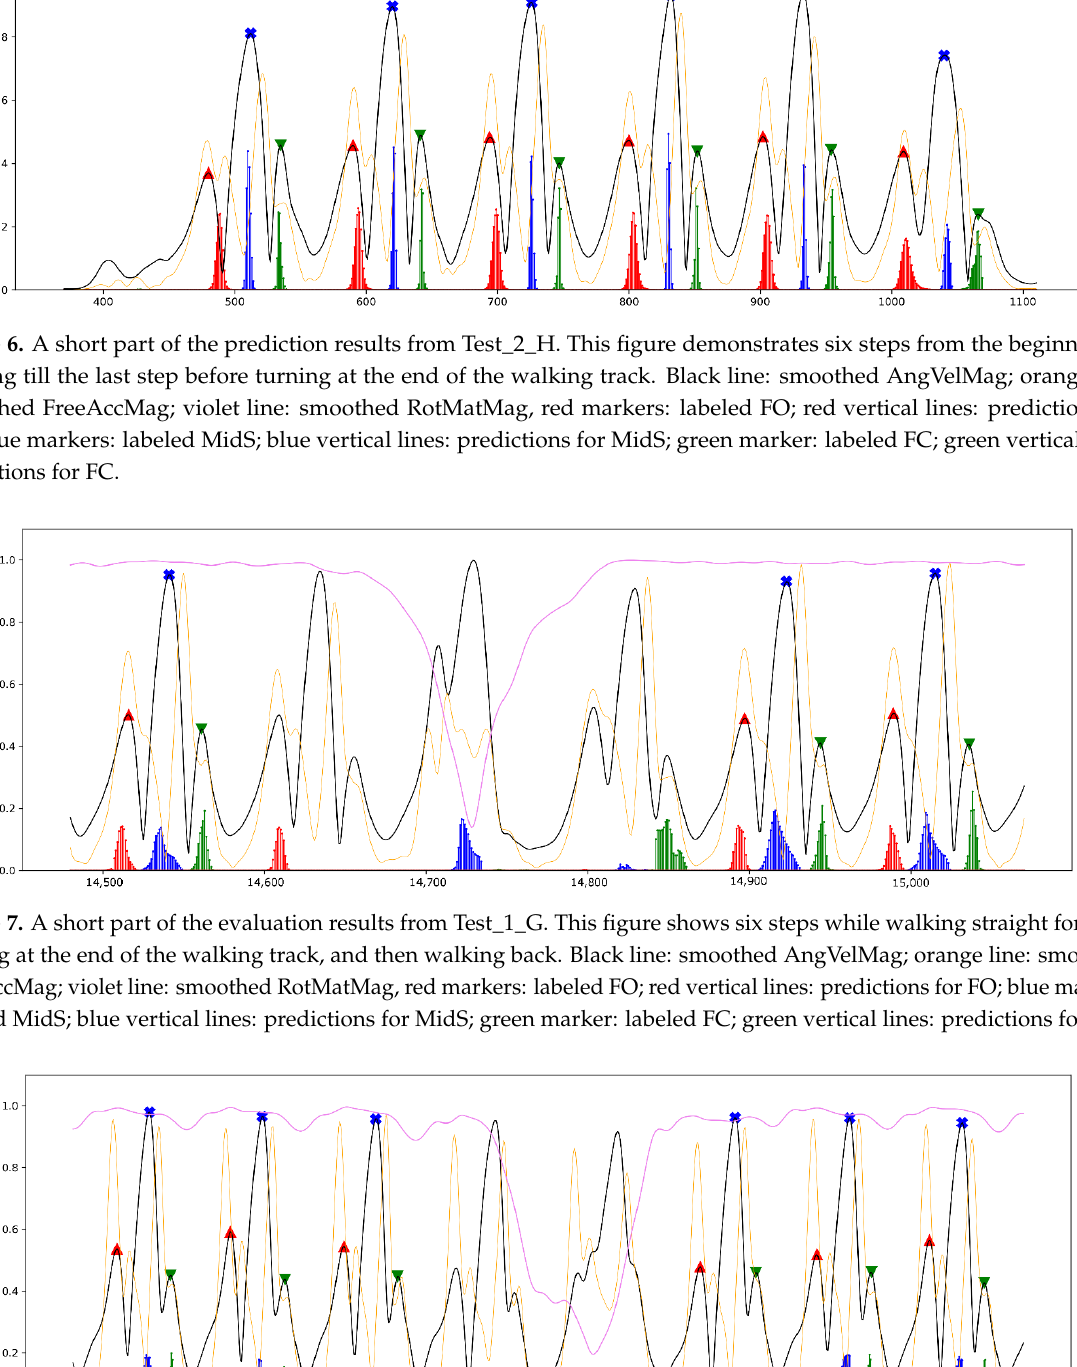
Figure 8. A short part of the evaluation results from Test_3_cLBP. This figure depicts eight steps while walking straight forward, turning at the end of the walking track, and then walking back. Black line: smoothed AngVelMag; orange line: smoothed FreeAccMag; violet line: smoothed RotMatMag, red markers: labeled FO; red vertical lines: predictions for FO; blue markers: labeled MidS; blue vertical lines: predictions for MidS; green marker: labeled FC; green vertical lines: predictions for